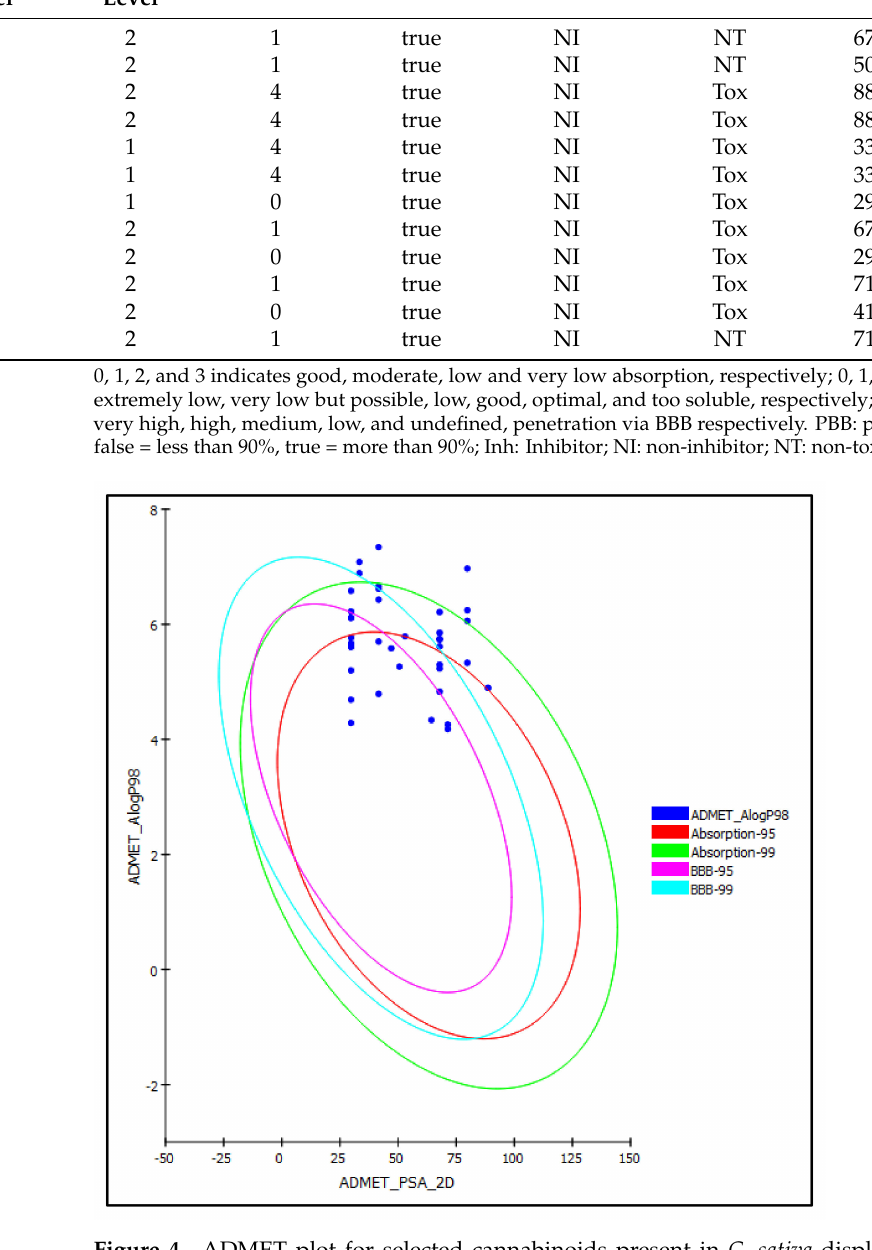
Figure 4. ADMET plot for selected cannabinoids present in C. sativa displaying 95% and 99% confidence limit ellipses corresponding to the blood-brain barrier (BBB) and the human intestinal absorption models in